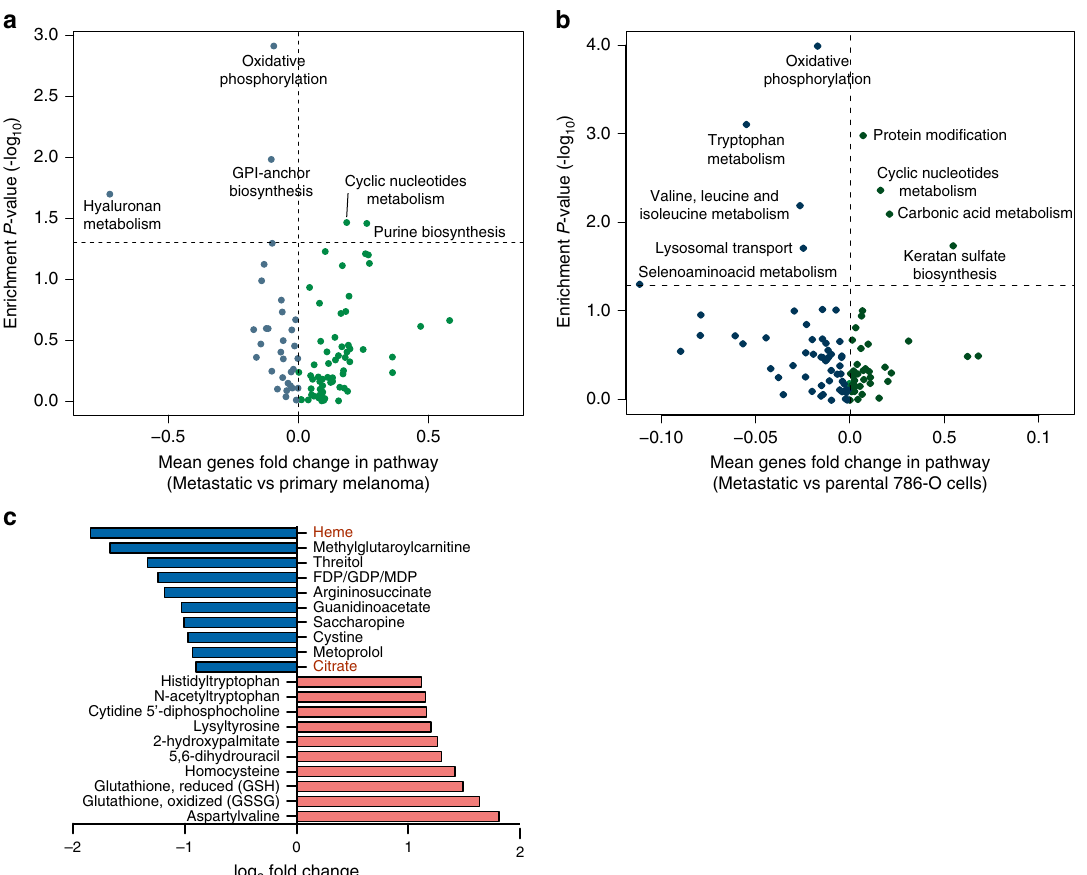
Figure 4 | Suppression of OXPHOS is a key metabolic feature of Skin Cutaneous Melanoma. ( a - b ) Volcano plot representation of mean fold change of genes in each pathway ( x axis) vs enrichment P -values ( y axis) of metastatic vs primary cancer samples ( a ) and of metastatic vs parental 786-O cell lines ( b ). ( c ) Fold changes in metabolite levels of metastatic vs non-metastatic ccRCC patients. Metabolites were ranked according to log 2 fold change. Top 10 downregulated and top 10 upregulated metabolites are shown. Data were obtained from Hakimi et al .